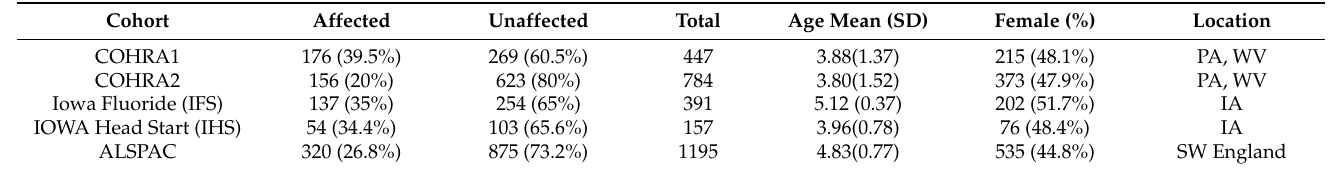
Table 1. Characteristics of cohorts used in in genome-wide association studies (GWASs) of early childhood caries